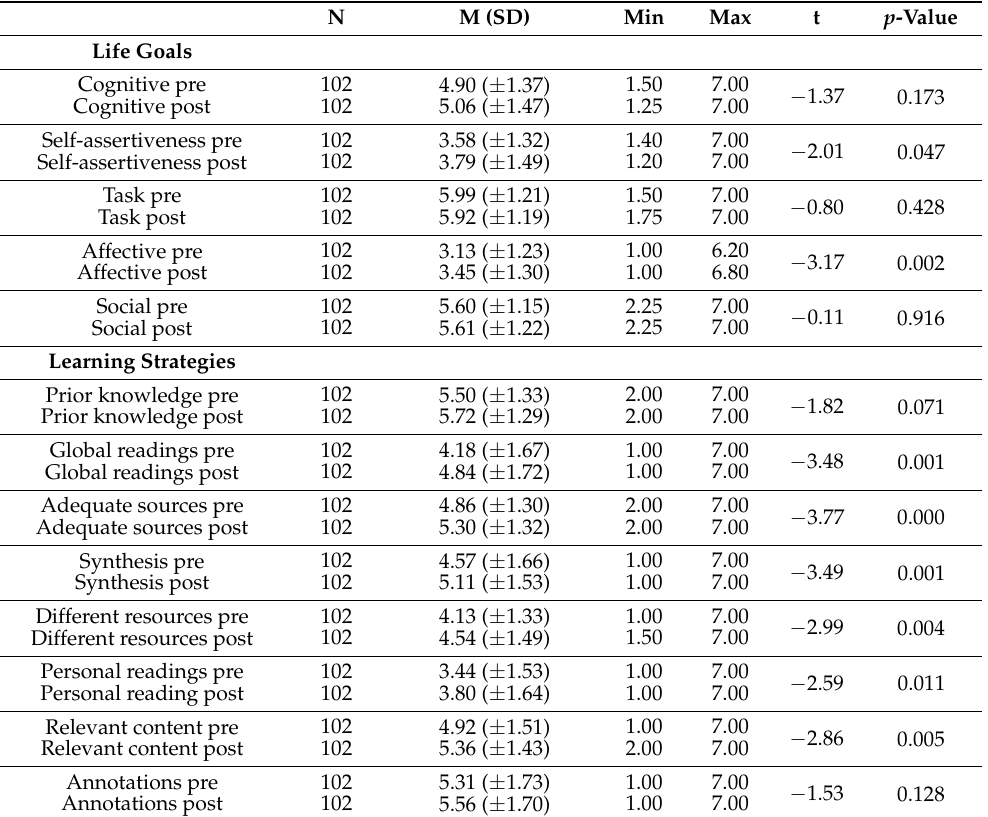
Table 2. Pre- and post-scores for the sub-variables of learning strategies and life goals motivating the study of study